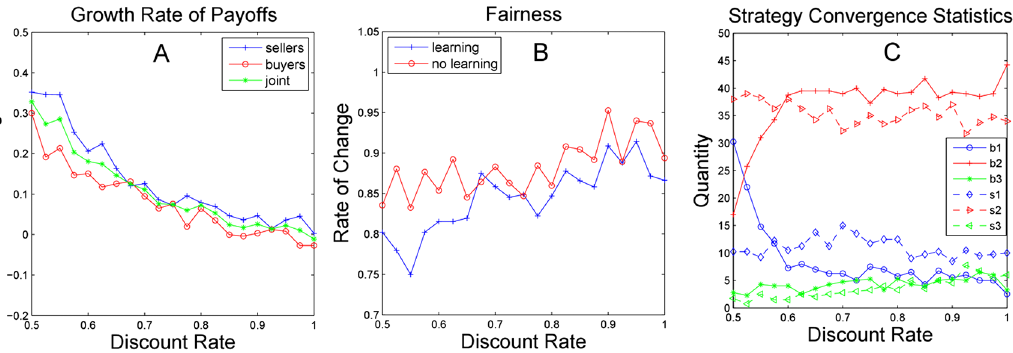
Figure 2. Negotiation performance of the agents. Figure 2A illustrates the growth rate of the average payoff with learning for buyers, sellers, and joint payoff compared to the growth rate without learning. Figure 2B illustrates the fairness comparison between the group with learning and the group without learning. Figure 2C shows the number of agents of each strategy in the convergence results, as every agent converges ultimately to a pure strategy.